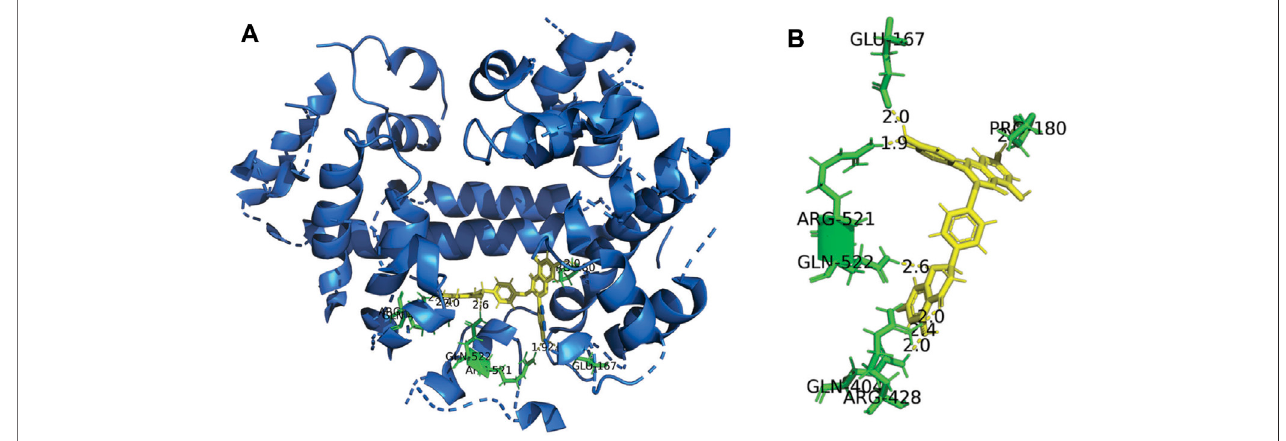
FIGURE5| Three-dimensionalstructureofHSAComplexedwithDF. (A) TheHSAstructurehasbeenrenderedwithribbonsandline,whileDFisrenderedastune. The inset shows a magni fi cation of the binding site with DF represented using stick model; (B) Representation of the amino acid residues in the binding site with their hydrogen bonds and van der Waals